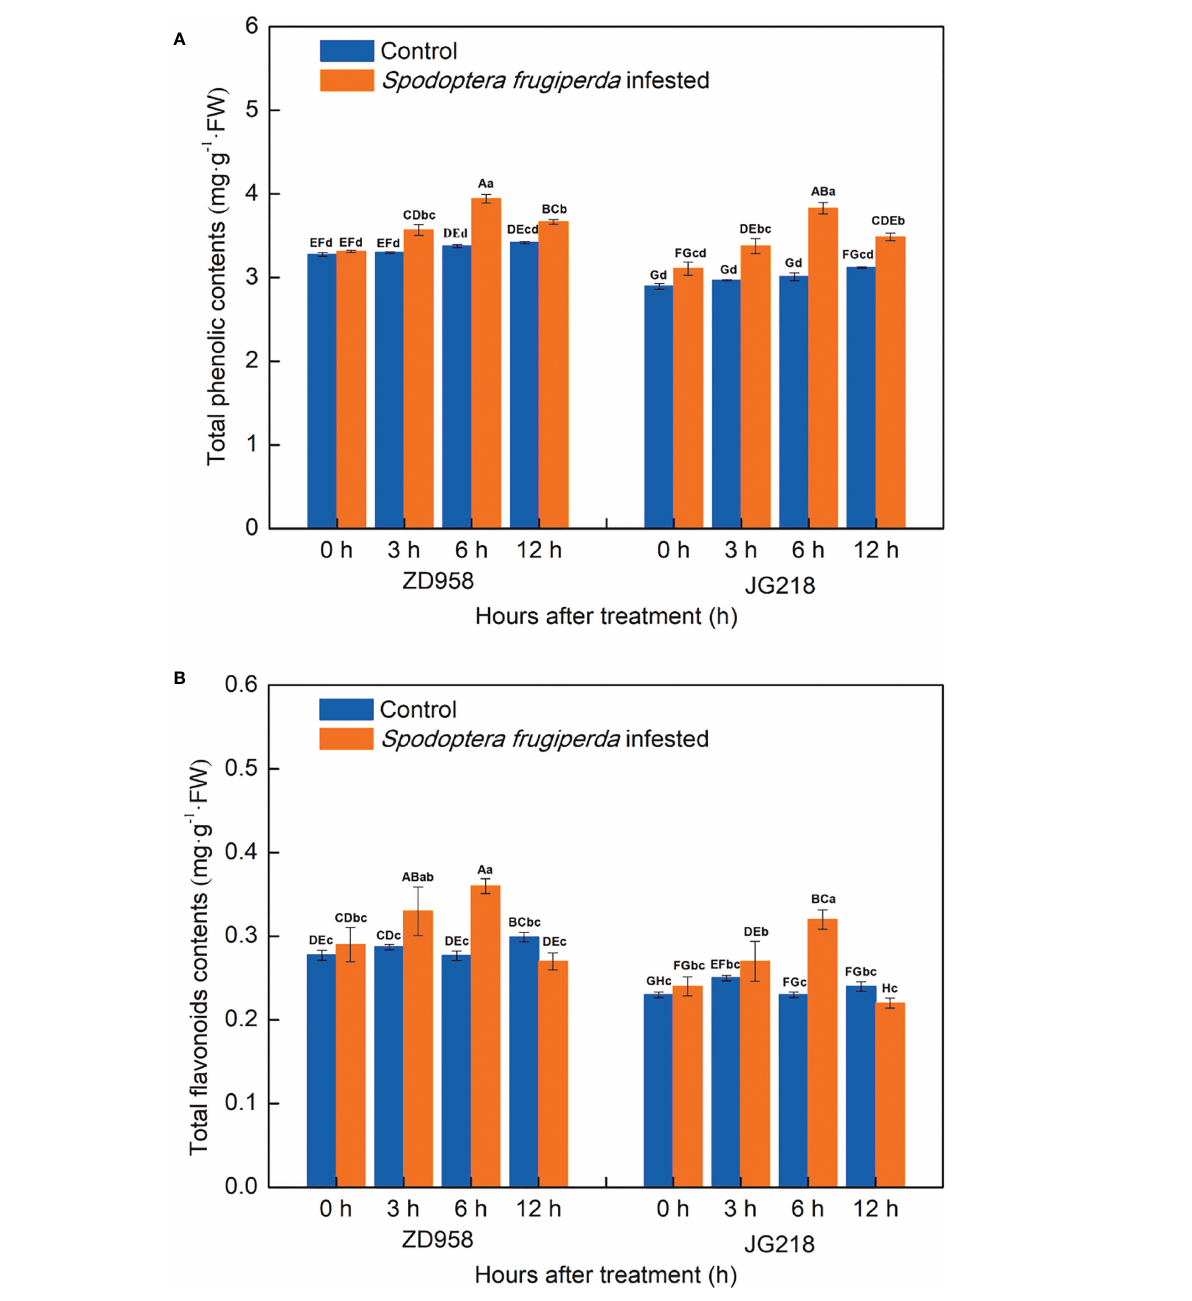
FIGURE 5 Effect of S. frugiperda infestation on total phenolic compound (A) and fl avonoid (B) contents in maize leaves. Data are shown as means ± SD ( n = 3, every n represents the mean of three seedlings). Different letters indicate signi fi cant differences at P < 0.05. Capital letters represent differences between the two maize cultivars, while lowercase letters indicate differences between treatments within the same